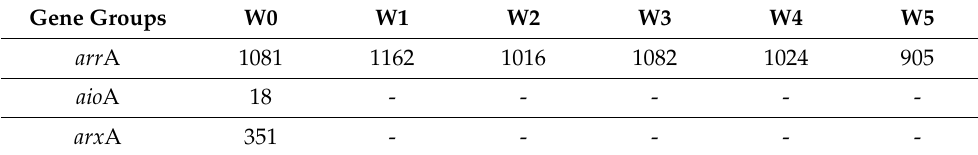
Table 3. OTUs of river water and groundwater.